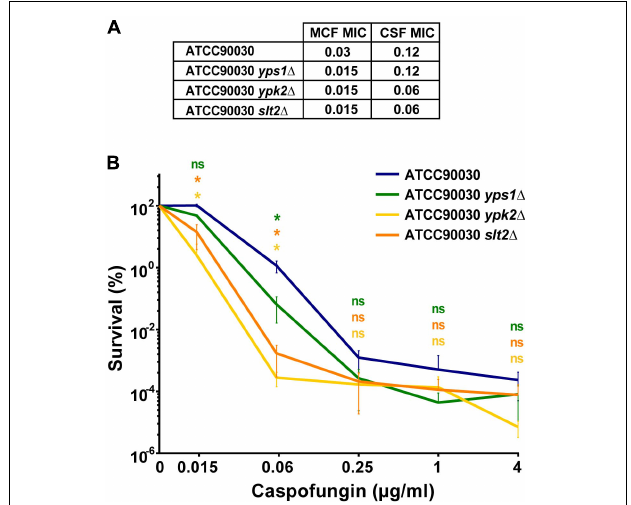
FIGURE 3 | In vitro echinocandin hyper-susceptibility of yps1 (cid:49) , ypk2 (cid:49) , and slt2 (cid:49) was confirmed in the ATCC90030 strain background. (A) Minimum inhibitory concentration (MIC) susceptibility testing to caspofungin and micafungin showed that the deletion mutants had lower or identical MIC-values than the wild-type parental strain. Echinocandin concentrations are shown in µ g/ml. (B) The in vitro tolerance assay confirmed that the mutants exhibited reduced drug tolerance compared to the parental ATCC90030 strain. Statistical significance was calculated using an unpaired t -test; p -value ≤ 0.05 is indicated with an asterisk (*), p -value > 0.05 is indicated as n.s. (not significant).